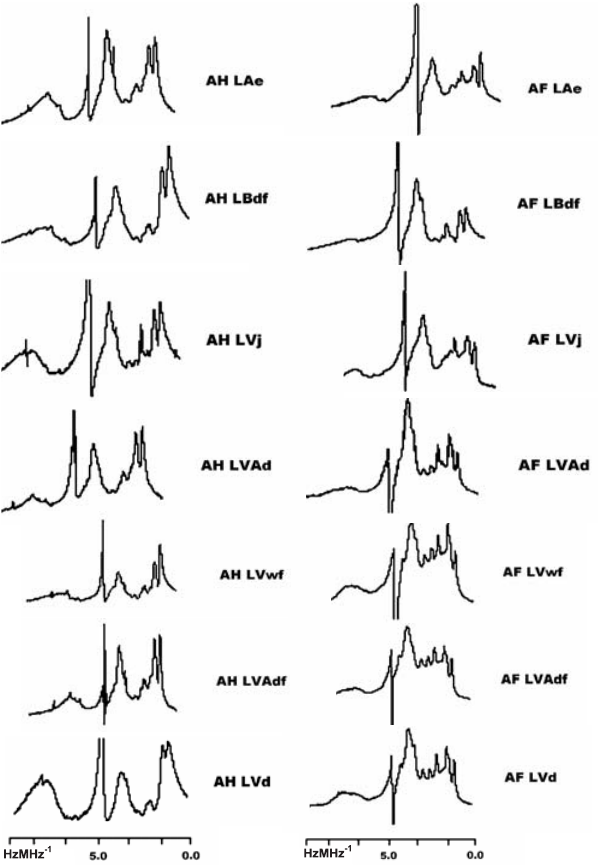
Figura 3. Espectros de RMN H 1 de ácidos húmicos (AH) e fúlvicos (AF) do horizonte superficial dos sete Latossolos